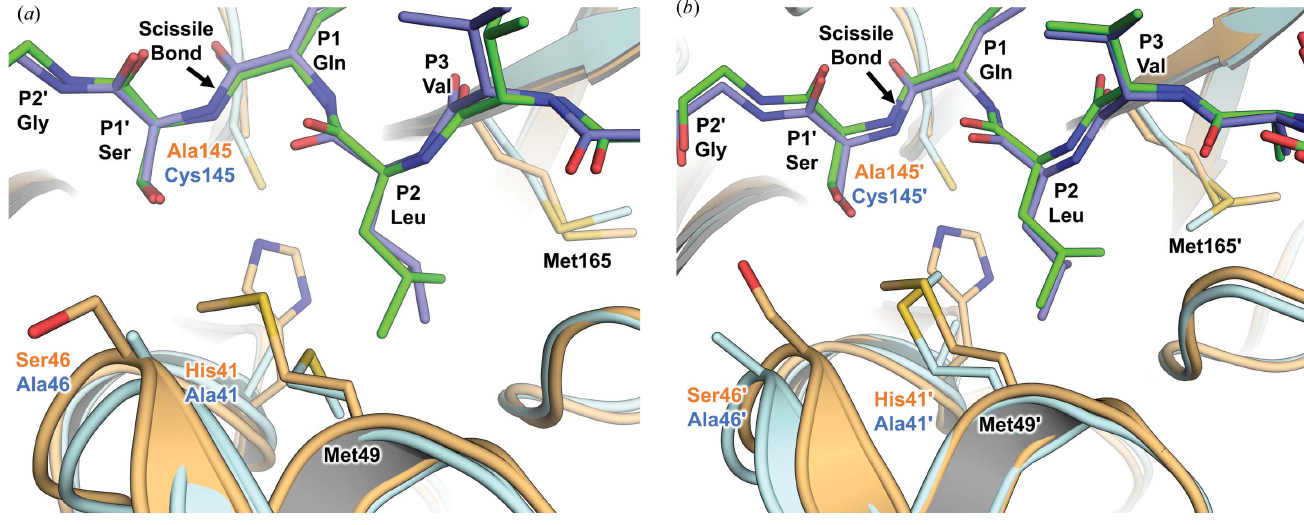
Figure 3 Comparison of substrate-bound M pro/C145A from SARS-CoV-2 (PDB entry 7n89) with M pro/H41A from SARS-CoV (PDB entry 2q6g). ( a ) Protomer A in M pro/C145A –substrate from SARS-CoV-2 (orange protein, green substrate) superimposed on the SARS-CoV M pro/H41A –substrate complex (cyan protein, slate substrate). Superposition was by a least-squares fit of C (cid:3) atoms of protomer B in PDB entry 2q6g to protomer A in PDB entry 7n89. ( b ) Protomer B in M pro/C145A –substrate from SARS-CoV-2 (orange protein, green substrate) superimposed on the SARS-CoV M pro/H41A –substrate complex. Superposition was by a least-squares fit of C (cid:3) atoms of protomer A in PDB entry 2q6g to protomer B in PDB entry